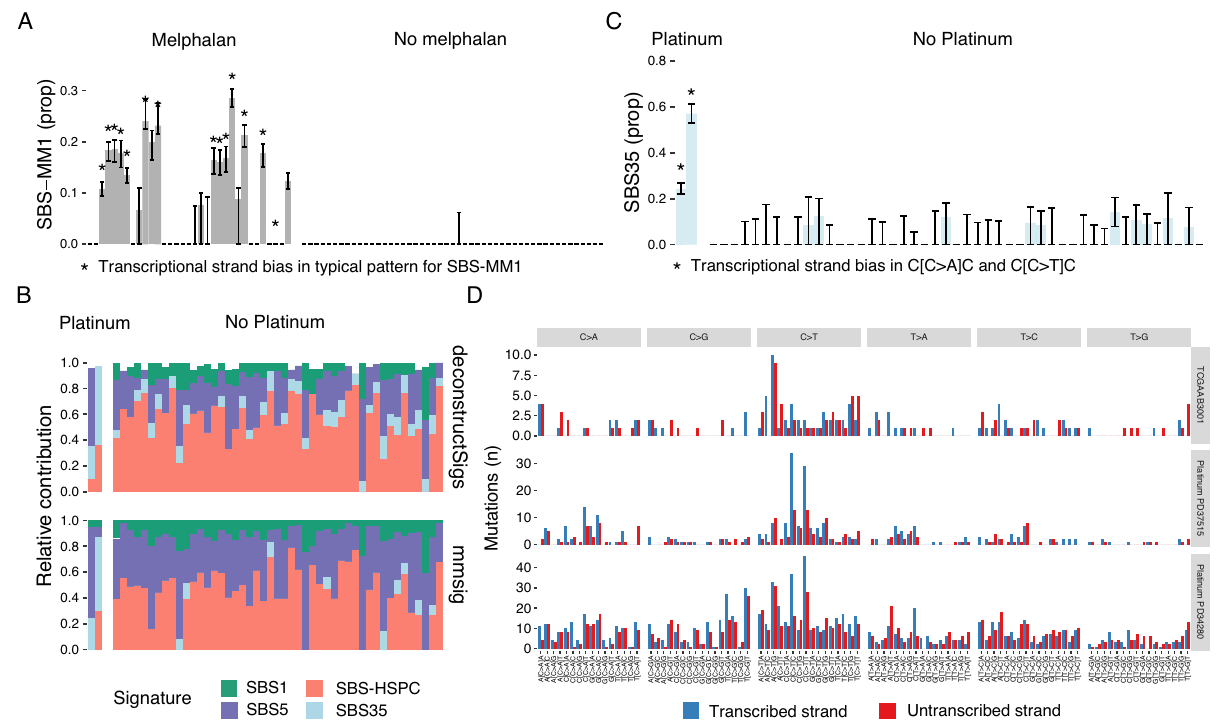
Fig. 4 Resolving uncertainty in mutational signature fi tting. A Bar chart showing the estimated SBS-MM1 contribution in 82 MM samples with and without prior melphalan exposure by mmsig (similar to Fig. 2B), with 95% CI estimated from 1000 bootstrapping iterations. Asterisks indicate statistically signi fi cant transcriptional strand bias in characteristic trinucleotide contexts (Poisson test p < 0.05). B Stached bar chart showing mutational signature pro fi les of 49 patients with acute myeloid leukemia (AML) with ( n = 2, left) and without ( n = 47, right) prior platinum exposure, estimated using deconstructSigs (top) and mmsig (bottom). SBS-HSPC is a mutational signature characteristic of hematopoietic stem cells. C Similar to A for 49 AML patients with and without prior platinum exposure. D Bar chart showing the number of mutations on the transcribed (blue) and untranscribed (red) strand in each trinucleotide context for three patients. On the top we show one patient who did not have prior history of platinum exposure, but where SBS35 was identi fi ed with the whole 95% CI above zero. The mutational signature pro fi le does not fi t the classic pattern of SBS35, however, and there is no sign of the characteristic transcriptional strand bias, suggesting a false positive call. The two lower panels show the patients with therapy-related AML who were exposed to platinum. Their mutational pro fi les are highly dominated by SBS35 with strong transcriptional strand